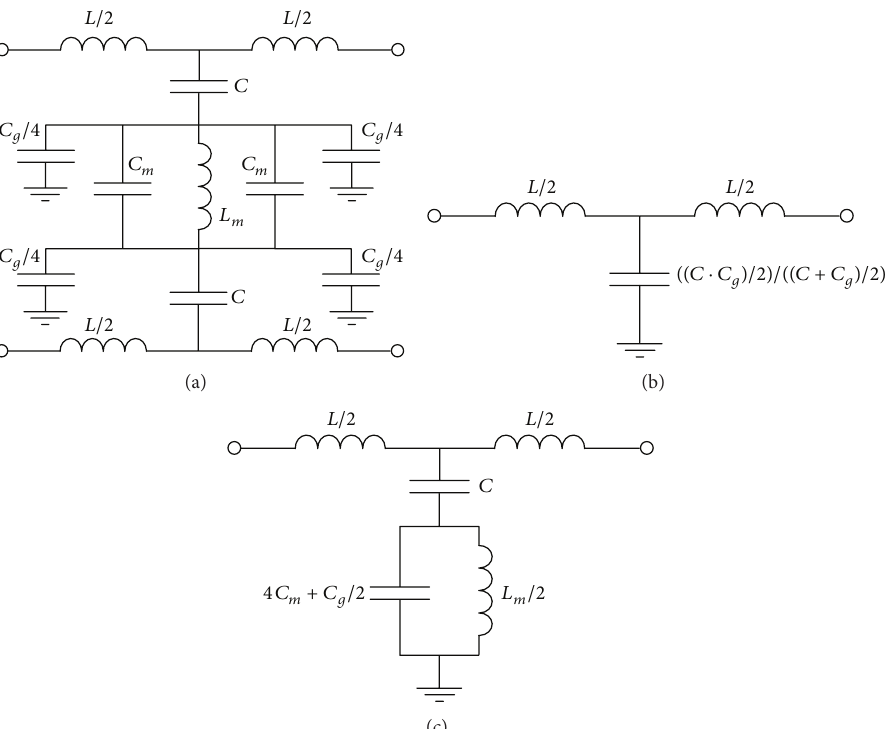
Figure 6: (a) Lumped element-equivalent circuit model of a differential microstrip line loaded with an MLC with the electric wall aligned with the line; (b) circuit model for the even mode, where the symmetry plane is an open circuit; (c) circuit model for the odd mode, the symmetry plane being a short